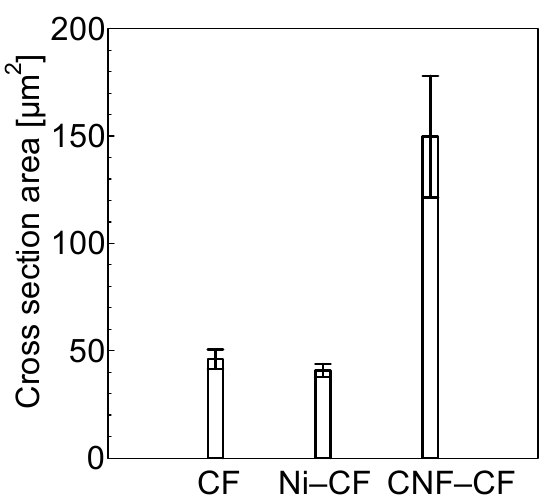
Figure 8. Cross section area of each carbon nanofilaments. (N = 6, mean ± S. D.).